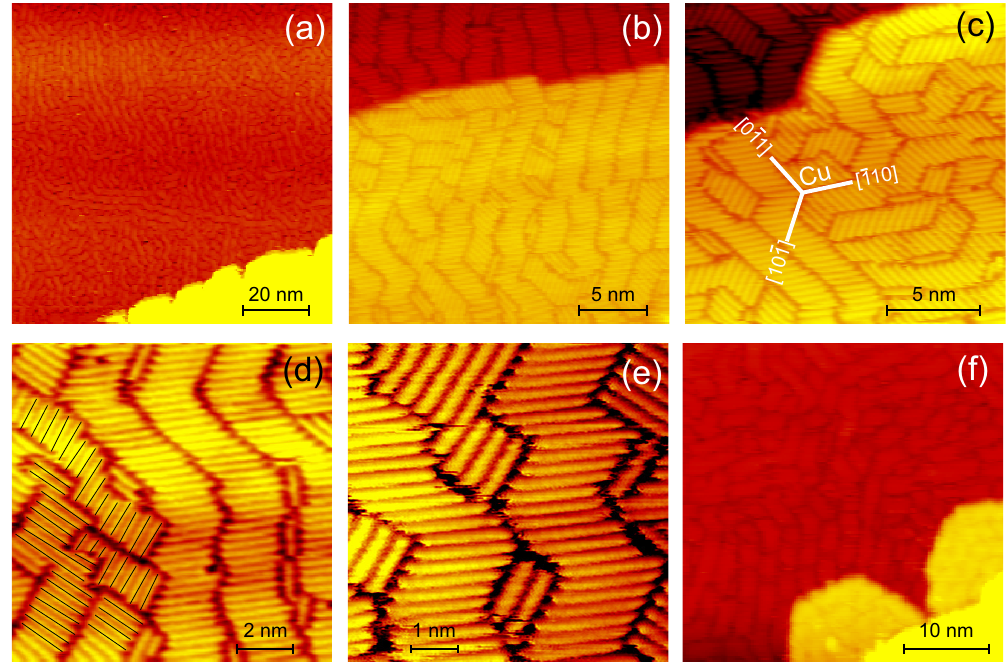
Figure 2. Ag/Cu(111) growth below 170 K: ( a – e ) STM images at increasing resolution for approx. 1 ML grown at 112 K ( f ) above 1 ML grown at 135 K; Cu (cid:104) 110 (cid:105) directions were determined from images of pristine surface with atomic resolution; lines in ( d ) symbolize length analysis (see text) deposition rates: ( a , f ) 0.65 ML/min; ( c , e ) 0.5 ML/min; tunneling parameters: ( a ) 2.1 V, 104 K; ( b ) 0.40 nA, 1.06 V;